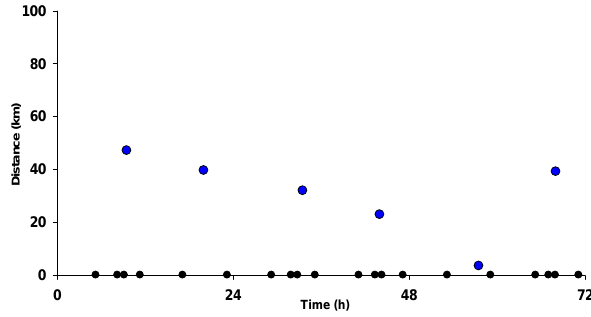
Fig. 1. Spatial-temporal scheme of radiosonde launches – black cir- cles, and satellite overpasses – blue circles denote average distance of individual FOVs within an